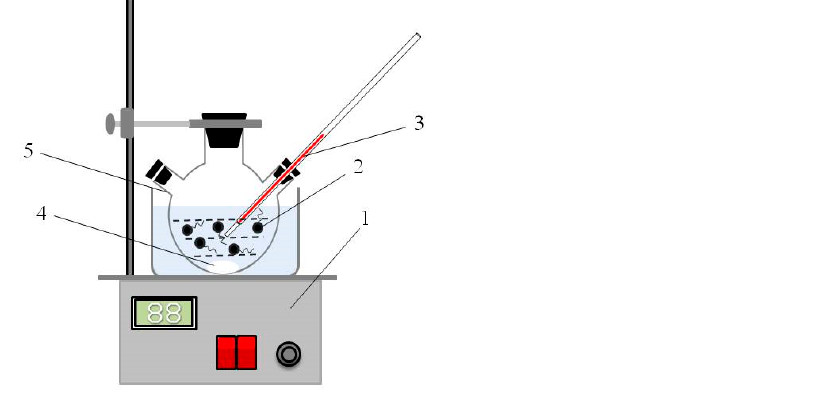
Figure 2. Schematic diagram of copper precipitation recovery experiment setup: 1—water bath thermostat; 2—SRSP; 3—thermometer; 4—magnetic rotor; 5—three mouth flask.